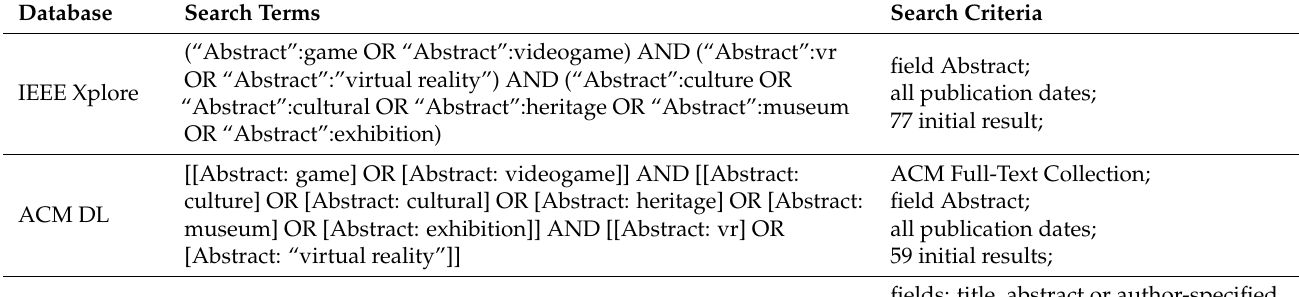
Table 1. Databases and search process followed in this study.